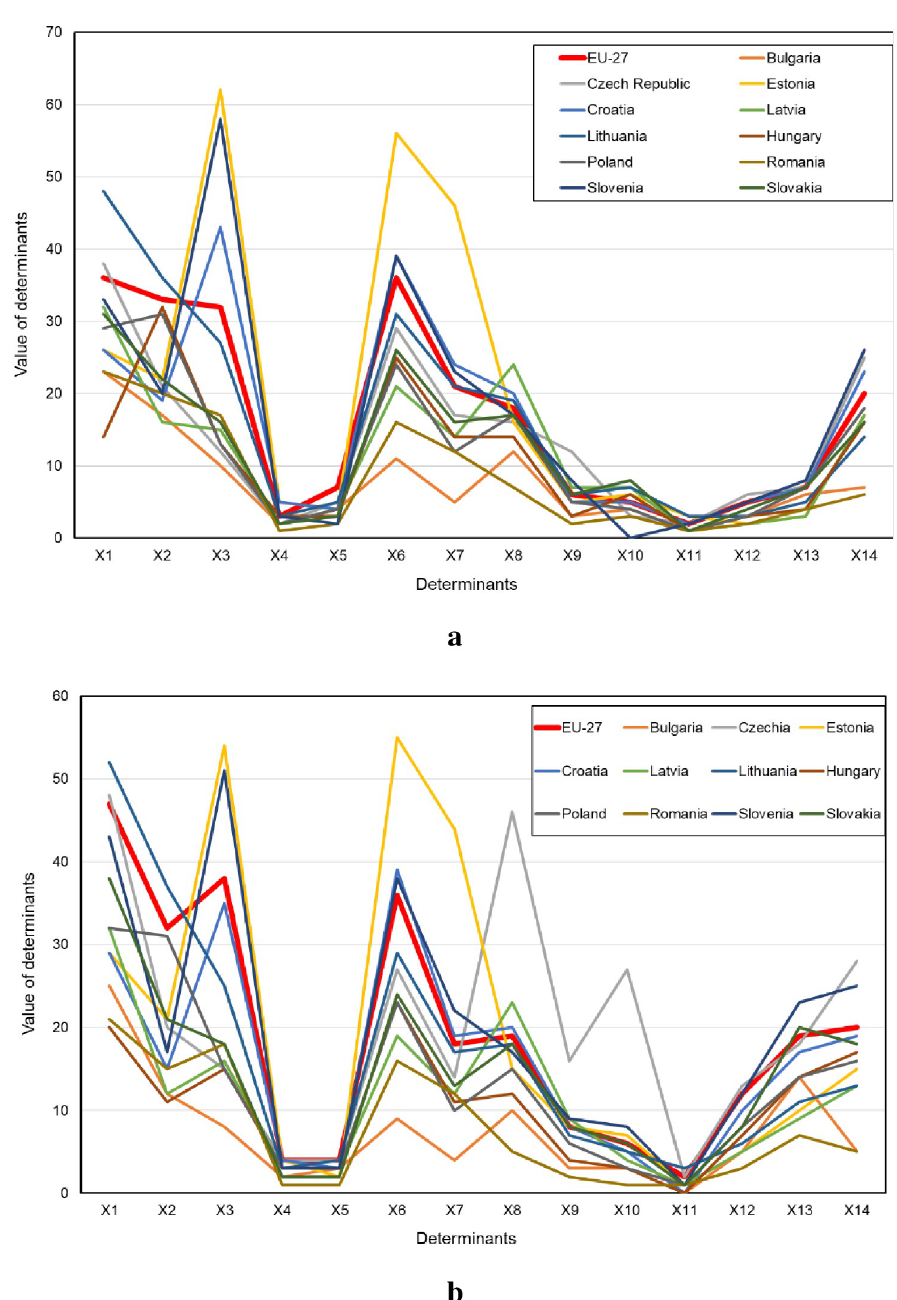
Fig 3. Summary of the values of studied determinants with regard to digital maturity among enterprises in the CEE countries compared to the EU countries (a–all enterprises, b–manufacturing enterprises). The results clearly show that the digital maturity determinants in the CEE countries are low versus the average values across the EU. The highest results among the CEE countries were obtained by the Czech Republic, Slovenia, Estonia, Croatia, and the lowest results by Bulgaria and Romania.